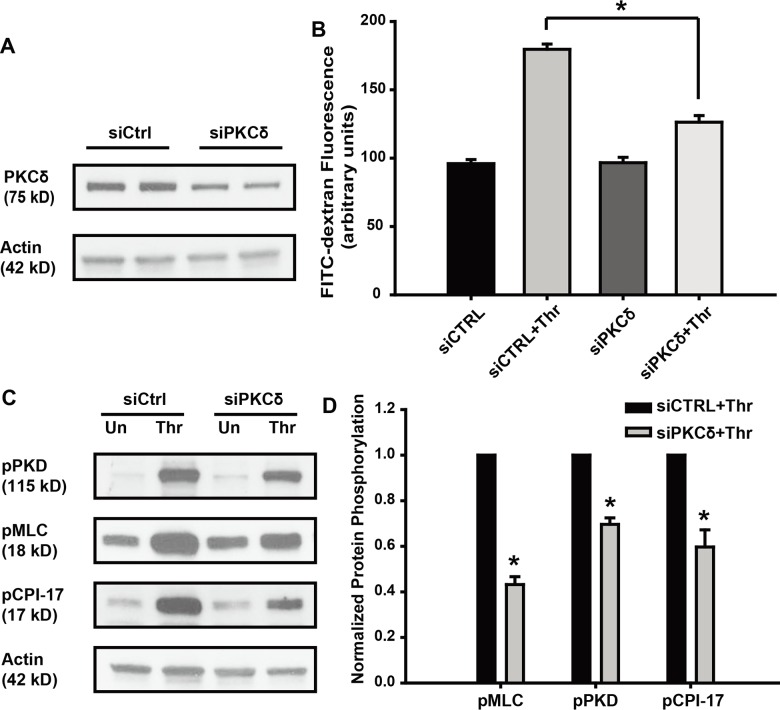
PKCδ silencing attenuates thrombin-induced permeability increase and phosphorylation of MLC, PKD and CPI-17.(A) EC were transfected with 100 nM small interfering RNA of PKCδ (siPKCδ) or scramble RNA control (siCTRL). 72 h later whole cell lysates were immunoblotted with antibodies as indicated. (B) EC transfected with PKCδ or control siRNA, were treated with thrombin (1 U/ml) for 1 h, and permeability was measured, the plot shows the fluorescence intensity of FITC-dextran (n = 3, * p < 0.05). (C) EC transfected with PKCδ or control siRNA were treated with thrombin (1 U/ml) for 10 min, whole cell lysates were immunoblotted with antibodies as indicated. (D) Normalized densitometry of MLC, PKD and CPI-17 phosphorylation is shown (n ≥ 3/condition, * p < 0.05).